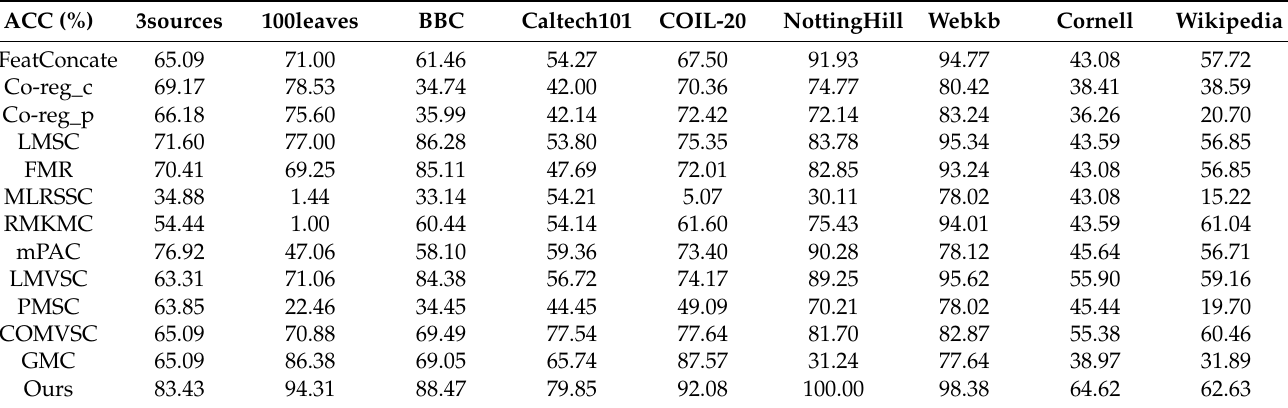
Table 3. The clustering performance comparison in terms of ACC on nine multi-view data sets.